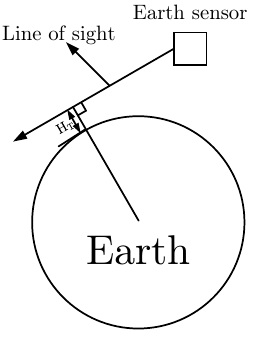
Figure 3. Geometry of tangent